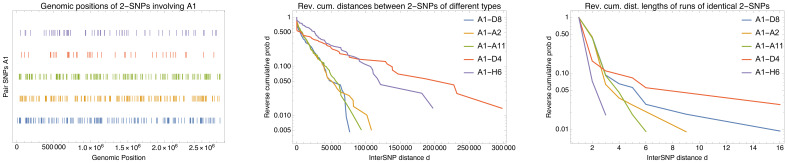
Distribution of the five most common 2-SNP patterns involving strain A1 along the core genome alignment.Left: Direct visualization of the positions of each of the 2-SNP patterns along the core genome alignment. Each dashed line corresponds to an SNP and SNPs are colored according to the 2-SNP type (see legend in middle and right panels) and ordered with the most common type at the bottom. Middle: Reverse cumulative distributions of the distances between consecutive SNPs of the same type. Each colored line corresponds to the distribution for one 2-SNP type (see legend). The vertical axis is shown on a logarithmic scale. Right: Reverse cumulative distribution of the length of runs of consecutive 2-SNPs of the same type. Each colored line corresponds to the distribution for one 2-SNP type (see legend). The vertical axis is shown on a logarithmic scale.